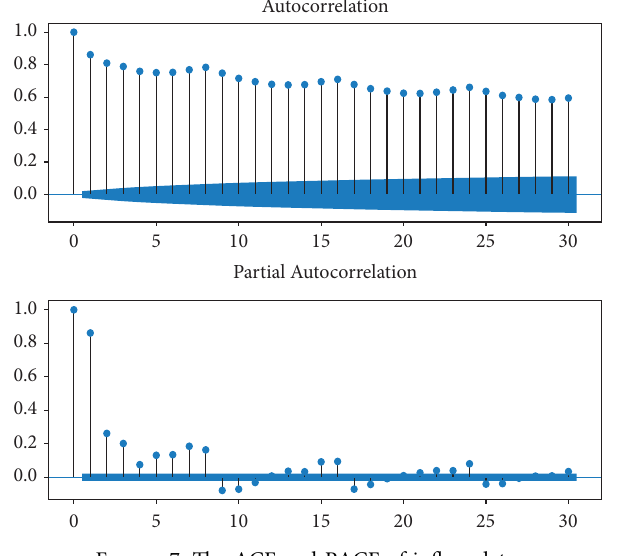
Figure 7: The ACF and PACF of inflow data.